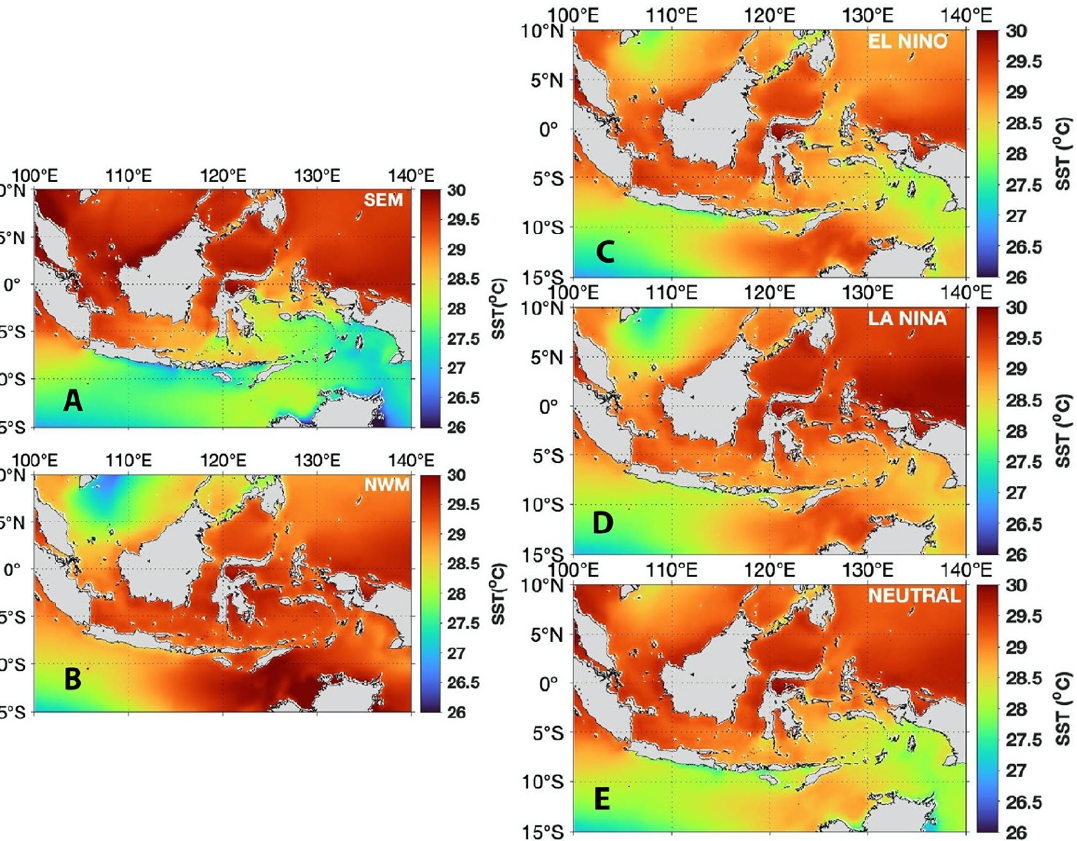
Figure 2. Average SST from June 2002 to June 2021 during ( A ) the southeast monsoon (boreal summer); ( B ) during the northwest monsoon (boreal winter); ( C ) El Niño; ( D ) La Niña, and ( E ) Neutral year.